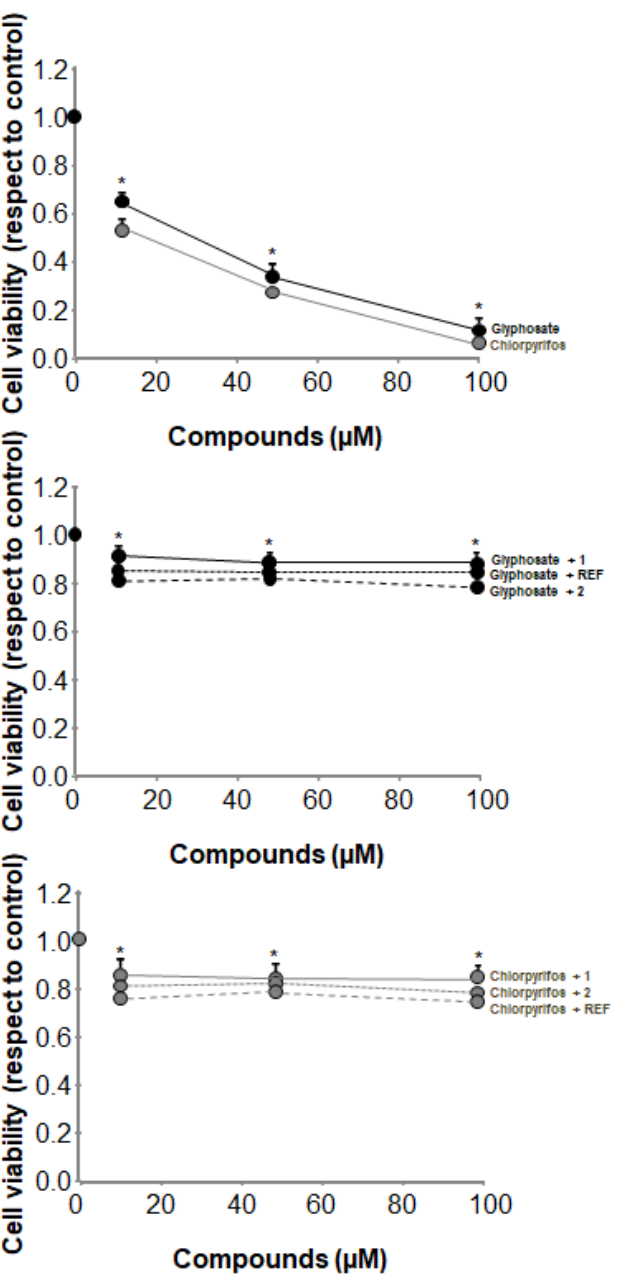
Figure 6. Effects of glyphosate and chlorpyrifos as individual compounds and in combination with compounds 1 , 2 , and resveratrol (REF) (all at the concentration level of 50 µM) on BEAS-2B cell viability (* Significance non-treated vs. chlorpyrifos or glyphosate + compounds under investiga- tion).